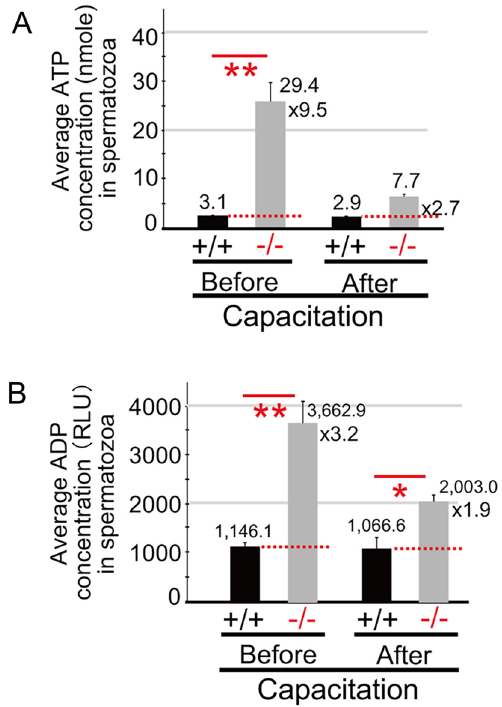
Figure 5. Average ATP and ADP concentrations in spermatozoa before and after capacitation. + / + : Odf4 +/+ . −/−: Odf4 −/− . Sperm activation (capacitation) was performed in TYH medium. ( A ) Average ATP concentration (nmol per 1 × 10 4 sperm). ( B ) Average ADP concentration (RLU per 1 × 10 4 sperm). In Odf4 +/+ , both ATP and ADP concentrations before and after capacitation were almost constant: 3.1 and 2.9 nmol and 1,146.1 and 1,066.6 RLU, respectively. In contrast, in Odf4 −/− , these values are not constant and show higher values than those of the control: 29.4 and 7.7 nmol and 3,662.9 and 2,003.0 RLU, respectively. Welch’s t test (two-tailed analysis). The raw data are shown in Fig. S9. * P < 0.05. ** P <